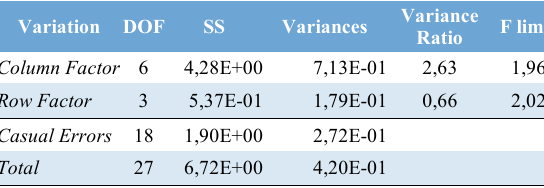
Tab. 2. Outputs of ANOVA Analysis on questions